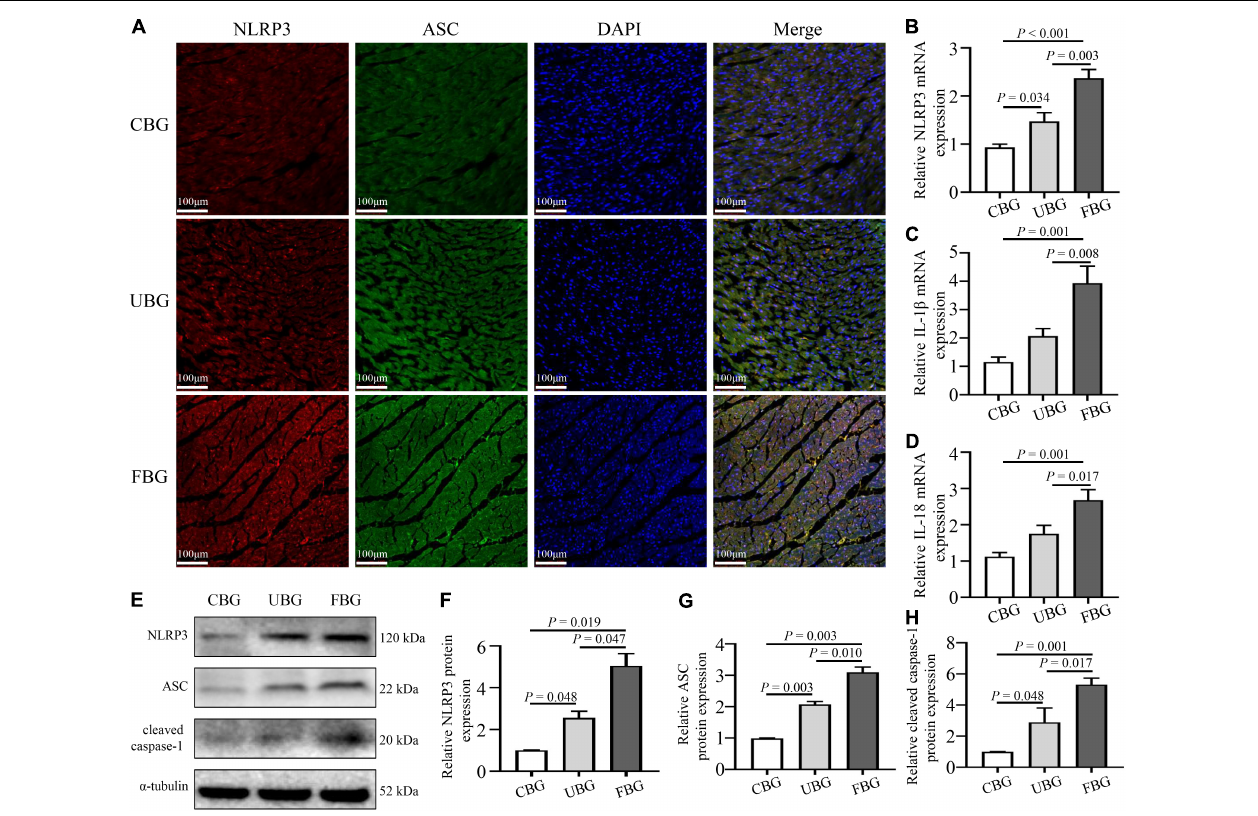
FIGURE 3 | Glucose fluctuations promoted the activation of NLRP3 inflammasome. (A) Immunofluorescence staining of NLRP3-ASC interaction in rat hearts. The heart sections were labeled with anti-NLRP3 (red), anti-ASC (green), and DAPI (blue) ( n = 3 per group). (B–D) The mRNA levels of NLRP3, IL-1 β and IL-18 in rat hearts of the three groups ( n = 4 per group). (E–H) The protein expressions of NLRP3, ASC and cleaved caspase-1 in rat hearts of the three groups ( n = 4 per group).